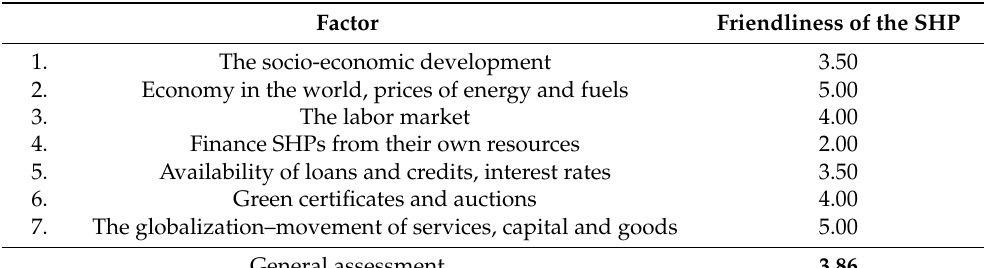
Table 2. The economic environment of SHPs in Poland in the context of its development